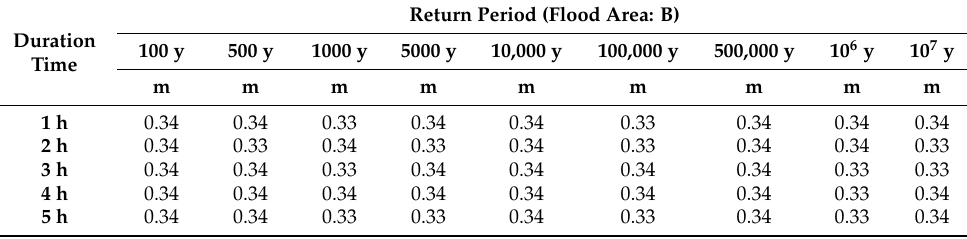
Table 7. Maximum flood depth in the control building of NPP 3 (elevation 80 ft, 2D analysis